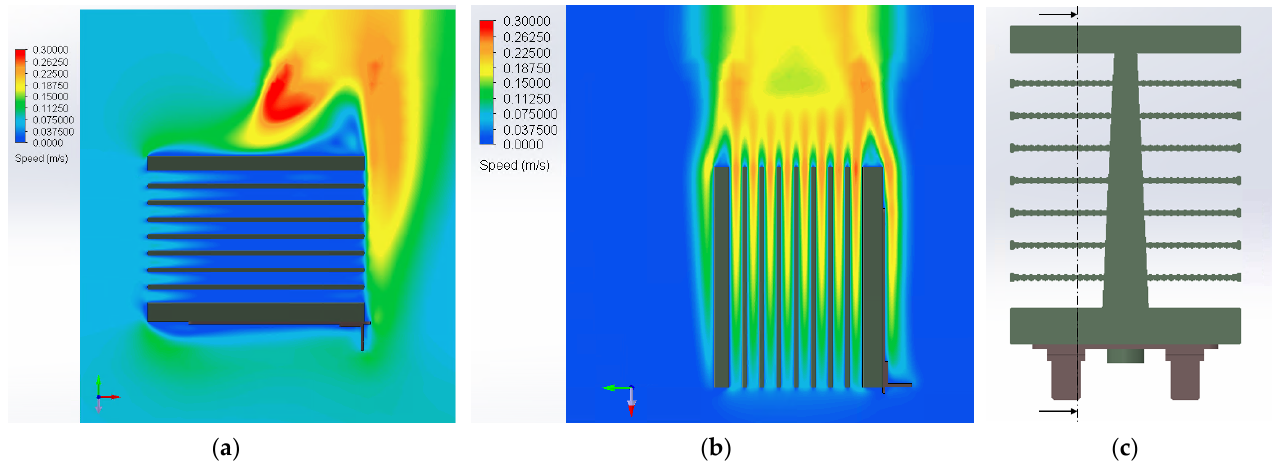
Figure 14. ( a ) Air velocity of Setup 1—section view; ( b ) Air velocity of Setup 2—section view; ( c ) Section plane.